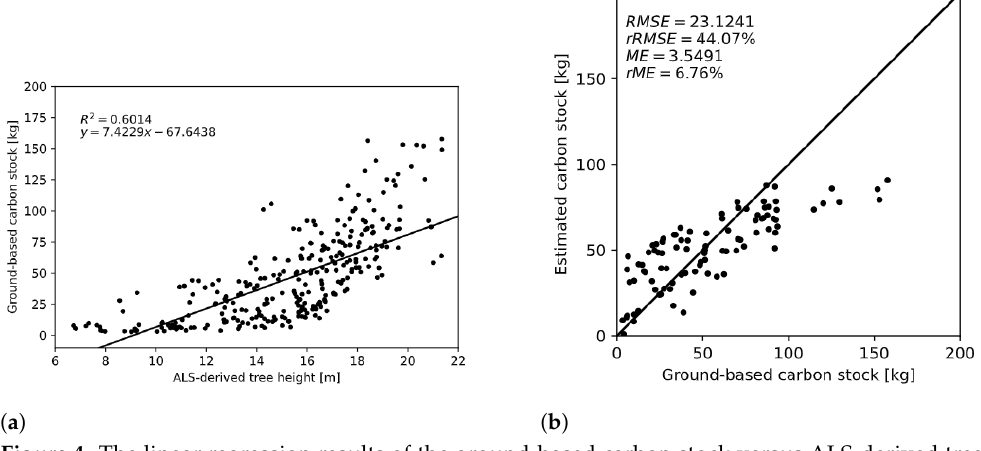
Figure 4. The linear regression results of the ground-based carbon stock versus ALS-derived tree height ( a ) and the results of ground-based carbon stock versus estimation from the ALS-derived tree height on the validation dataset ( b